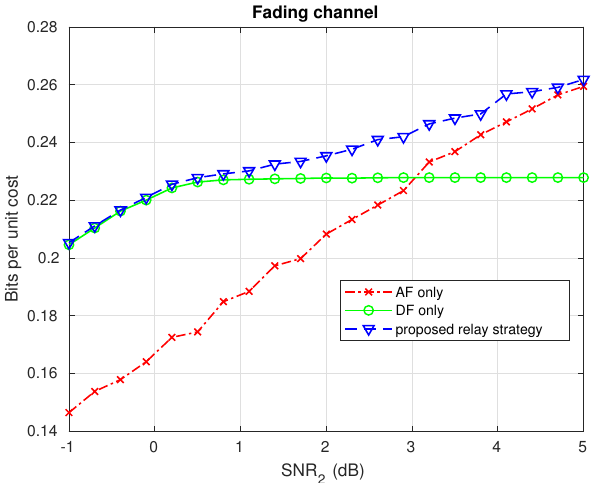
Figure 9. Average throughput of different relay strategies in fading channel.